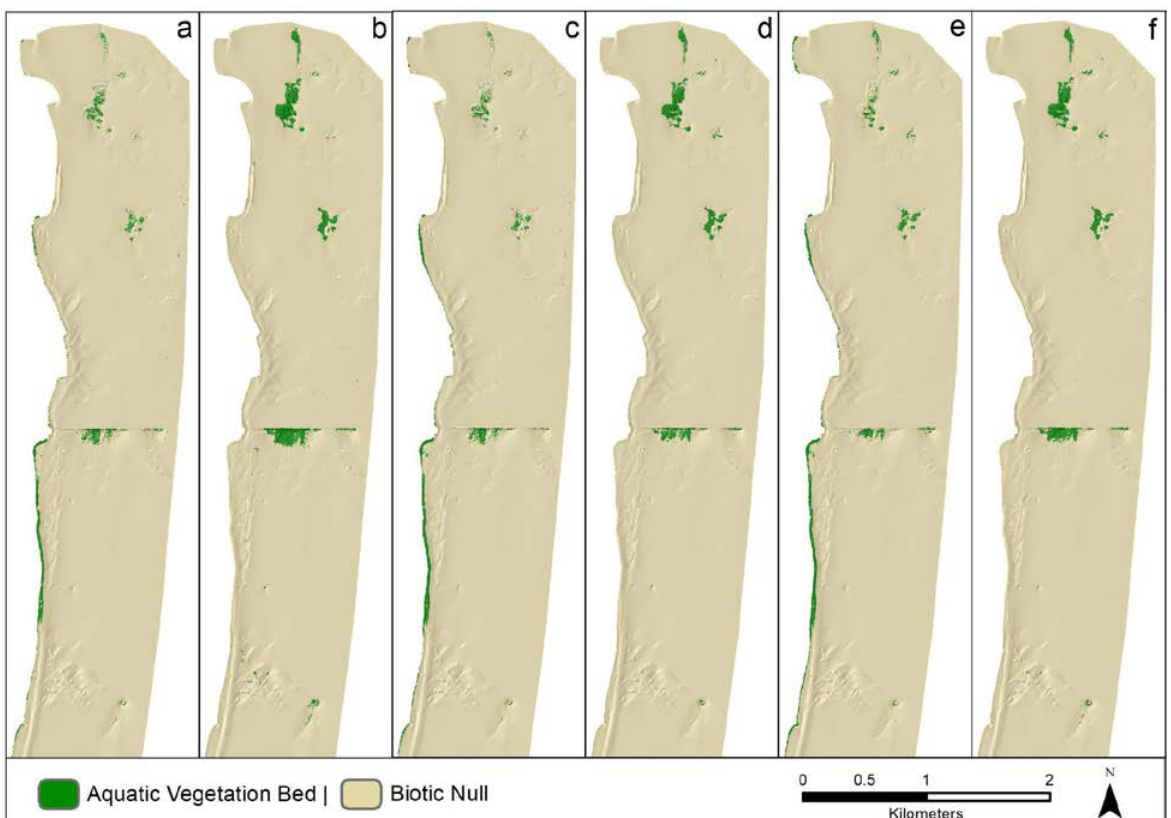
Figure 18. Tier 1 biotic component classification results using airborne data combinations for the north-central section of the study area: ( a ) AB DE + CA MNF FU + CA MNF WLR, ( b ) AB DE + CA MNF FU + CA MNF WLR with additional ROIs, ( c ) CA MNF FU + CA MNF WLR, ( d ) CA MNF FU + CA MNF WLR with additional ROIs, ( e ) AB RF + AB DE + CA MNF FU + CA MNF WLR, and ( f ) AB RF + AB DE + CA MNF FU + CA MNF WLR with additional ROIs.